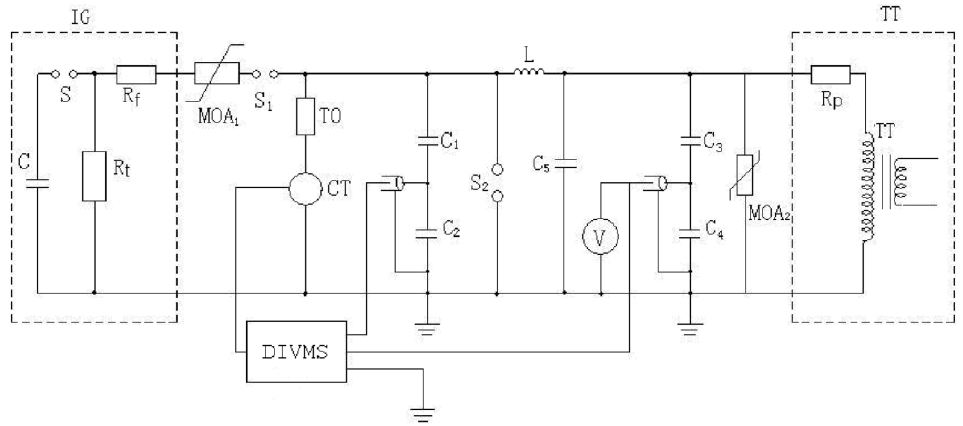
Figure 12. Power frequency continuous current interruption test circuit. CT: current transformer; S 1 :